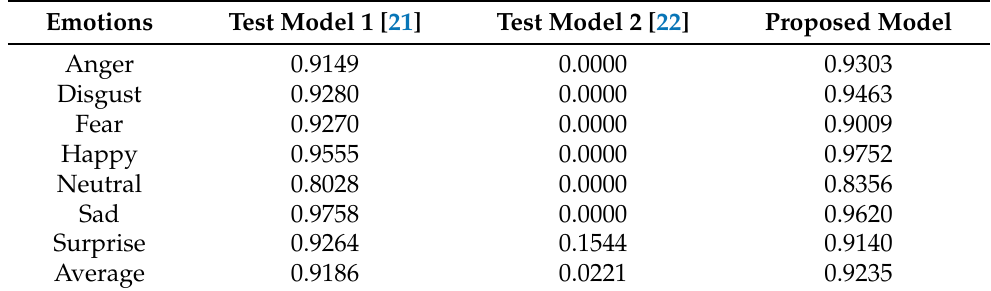
Table 29. Precision comparison between all three models with respect to observation 2 of Experiment 1 with 100